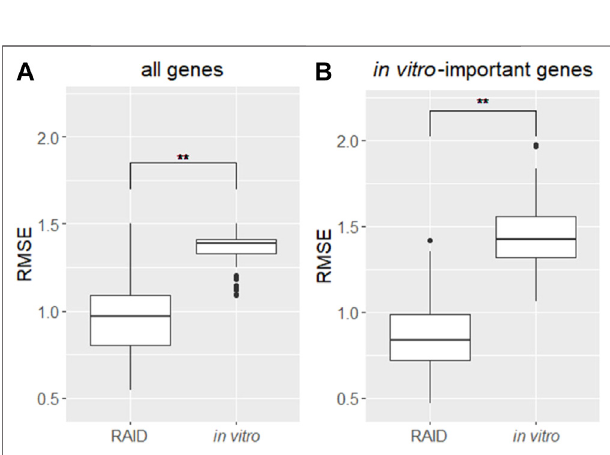
FIGURE 6 | Distribution of RMSEs of a virtual microarray (RAID) and in vitro data of (A) all genes and (B) in vitro genes having importance (contribution) in predictive models. **p < 0.01 (Welch ’ s t-test).